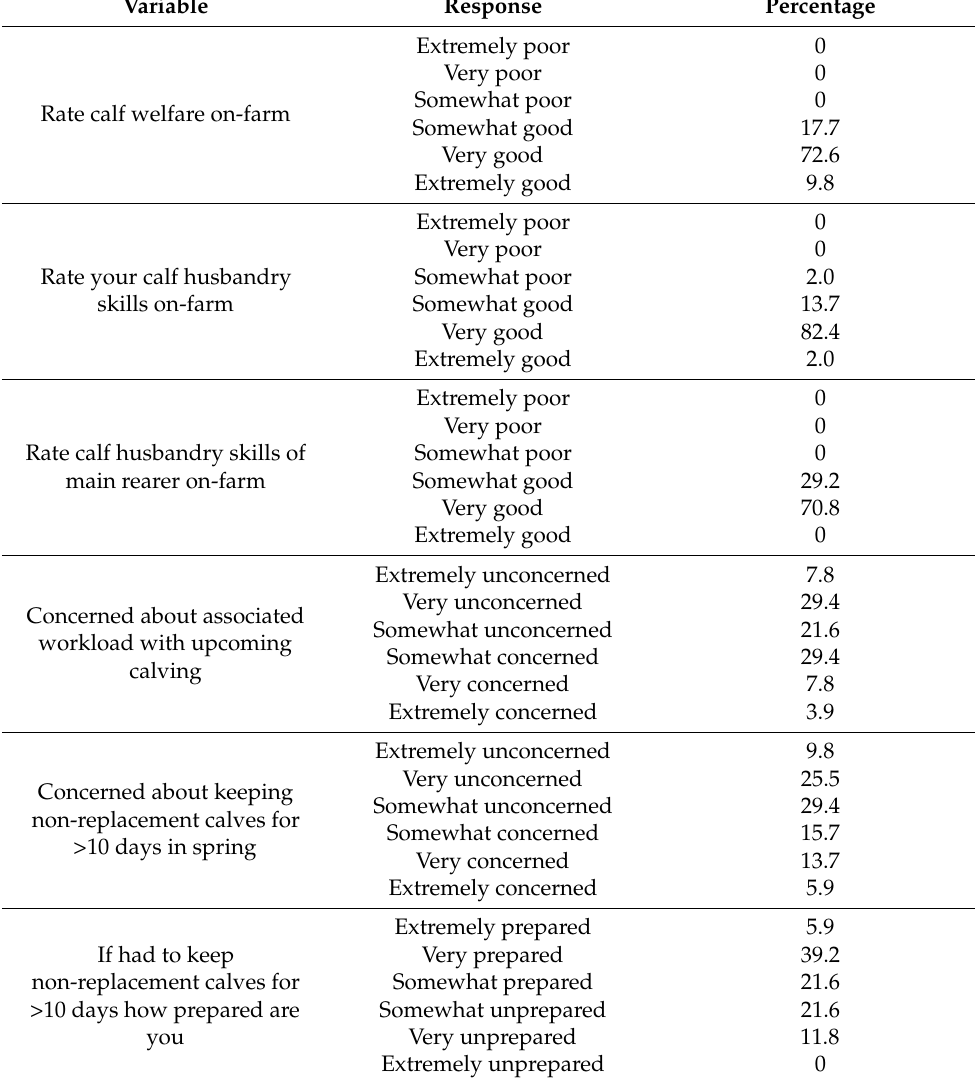
Table 1. Farmer opinions (N = 51) on calf related